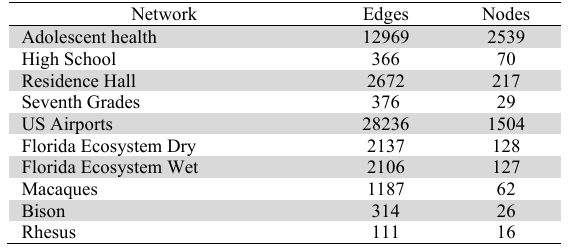
EQ measure Comparison between OSLOM and LCFE